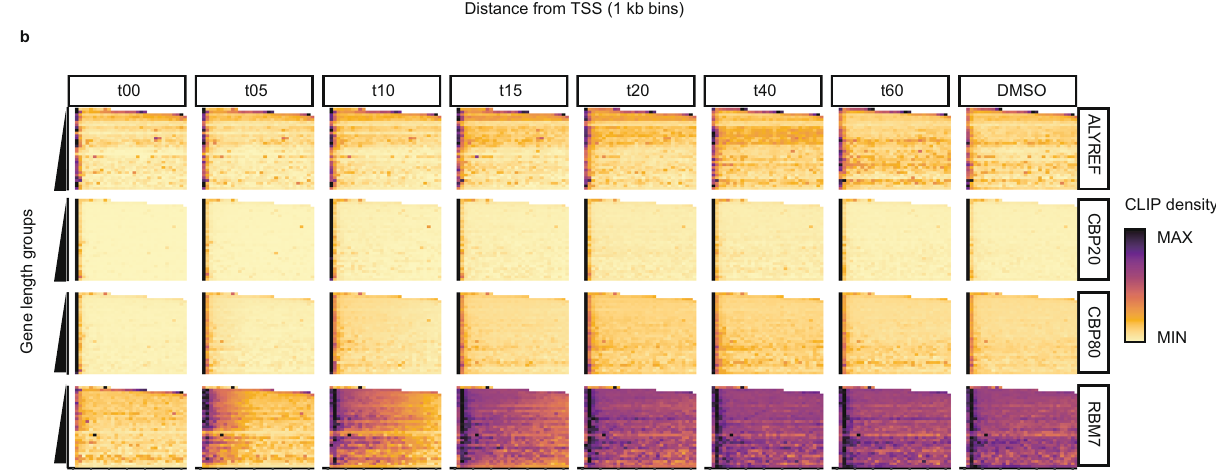
mark the approximate speed of RNAPII transcription (3.5kb/min). 23,512 TUs were usedinthisanalysis. b Spatiotemporalheatmapsasin a ,butzoominginonthe fi rst 30kb of each TU. Source data are provided as a Source Data fi